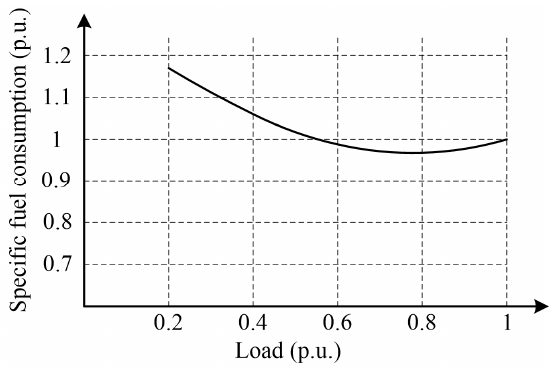
Figure 9. Typical specific fuel consumption curve of a marine diesel-engine.